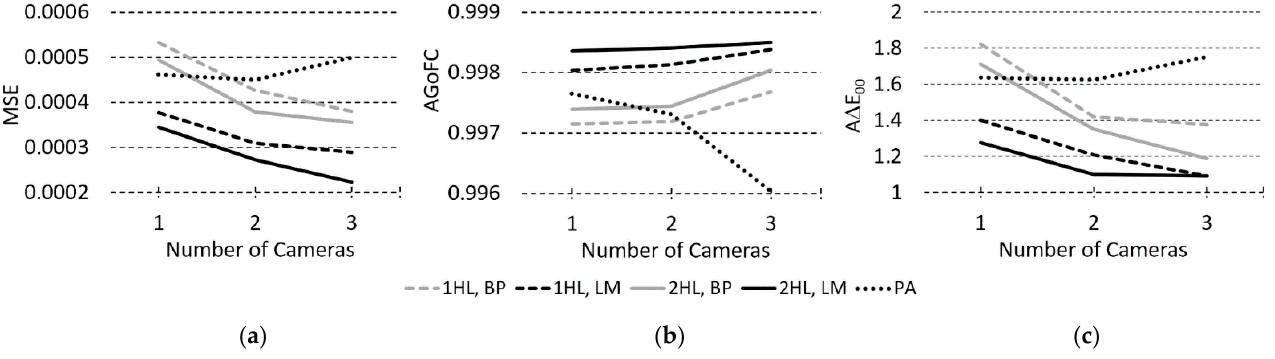
Figure 7. Examples of an in-number-of-cameras average best test set performances: ( a ) MSE for LS size of 650, ( b ) AGoFC for the largest LS size, and ( c ) A ∆ E* 00 (F2 illuminant) for the smallest LS size, according to the number of cameras.